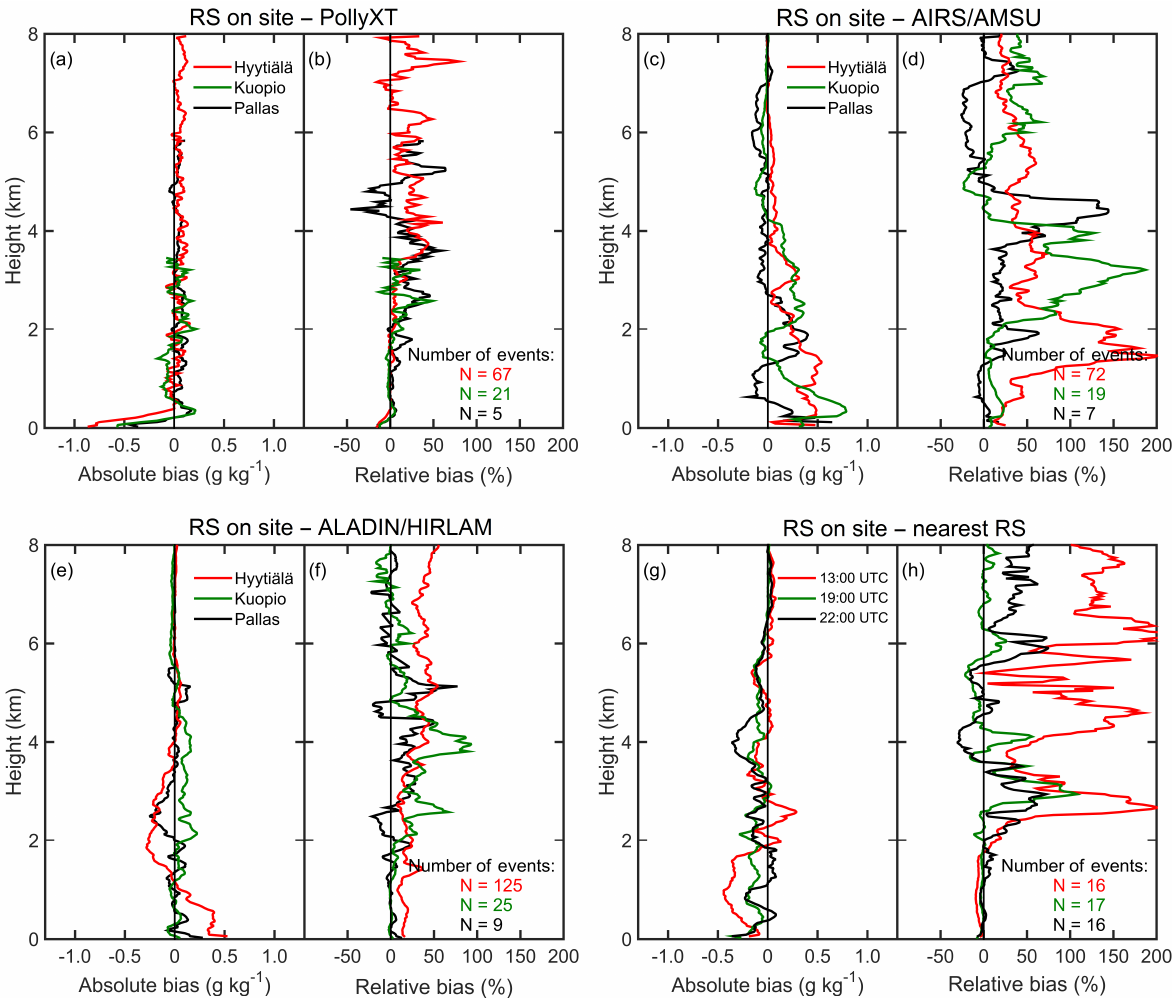
Figure 3. Comparisons between the on-site radio soundings and Polly XT , AIRS/AMSU, ALADIN/HIRLAM and nearest available radio soundings (for Kuopio site only). The various campaigns are indicated with different colors: red for Hyytiälä, green for Kuopio and black for Pallas. For the comparison between on-site RS and the nearest RS ( g and h ), the different colors indicate the three different on-site RS launch times compared to that of the nearest RS at 18:00UTC. A 30min average of the lidar signals is used. The trajectory method is used to select an appropriate WVMR profile from satellite data. The WV profile from ALADIN/HIRLAM model was selected from the nearest time point. Panels (a, c, e, g) show the mean absolute bias from the on-site RS. Panels (b, d, f, h) indicate the corresponding mean relative bias. Height is above ground